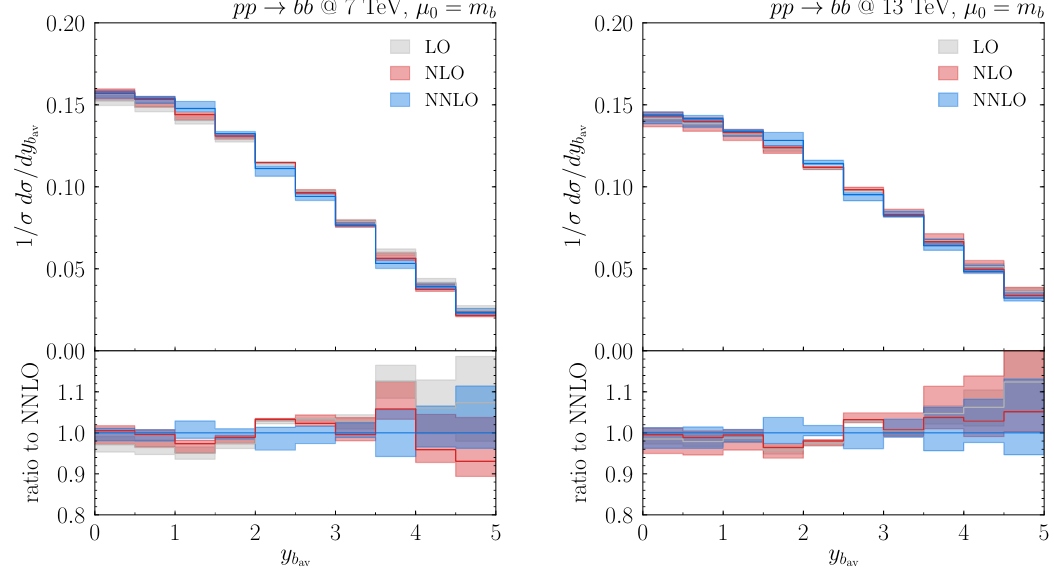
Figure 8 . Normalised rapidity distribution at the LHC for p s = 7 TeV (left) and 13 TeV (right). The lower panels show the ratio to the NNLO